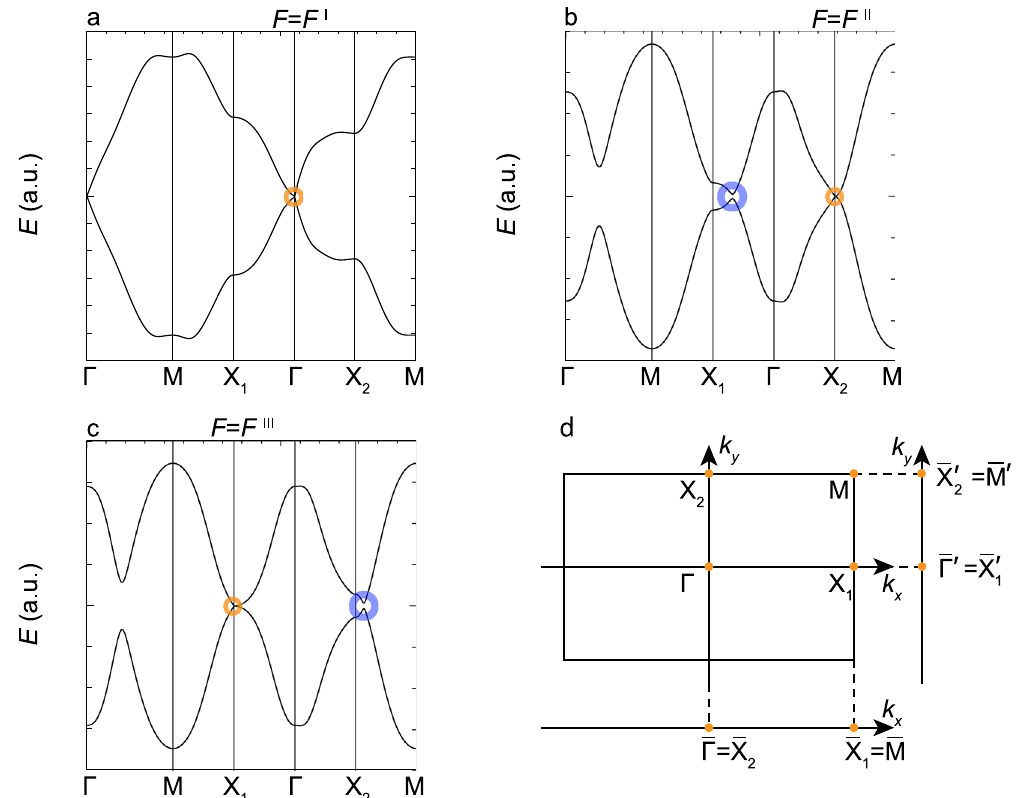
Figure 3. Quasienergy dispersion of 2D-bulk band E ( k ) . ( a ) Shown is E ( k ) at F I x , where E p ( 1 ) ( k ) and E s ( − 1 ) ( k ) are degenerate at the Ŵ point (open yellow circle). ( b ) The same as the ( a ) but at F II x with the degeneracy at the X 2 point (open yellow circle) and the nearly degenerate valleys between the Ŵ and X 1 points (open blue circle). ( c ) The same as the ( a ) but at F III x with the degeneracy at the X 1 point open yellow circle) and the nearly degenerate valleys between the X 2 and M points (open blue circle). ( d ) Shown are the high-symmetry points of Ŵ , X 2 , X 1 and M in the 2D-BZ with their projection onto the k x -axis denoted as ¯ Ŵ , ¯ X 2 , ¯ X 1 and ¯ M , and onto the k y -axis denoted as ¯ Ŵ ′ , ¯ X ′ 2 , ¯ X ′ 1 and ¯ M ′